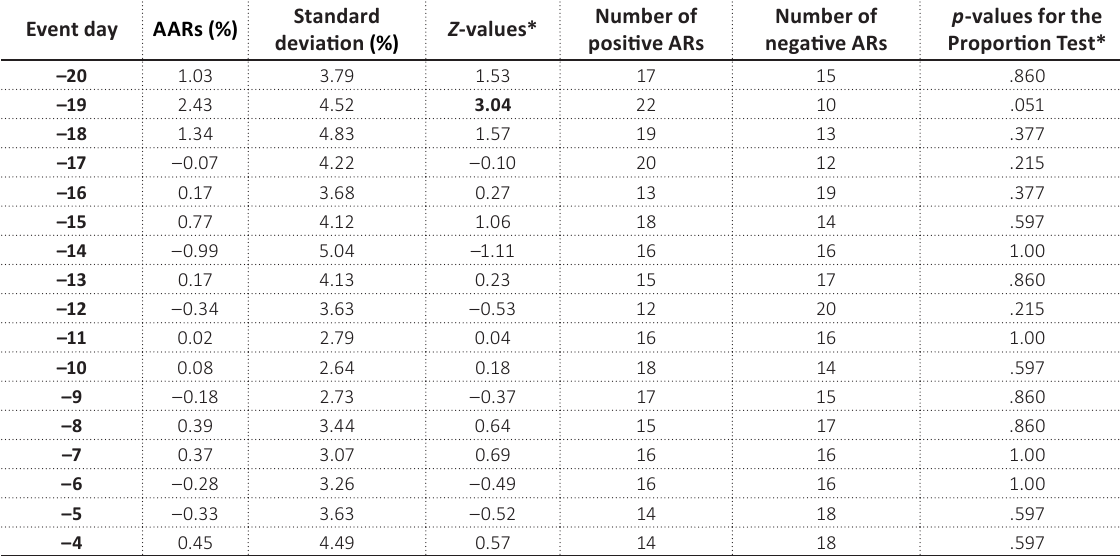
Table 5. AARs and Z -values – Announcement Day (split ratio